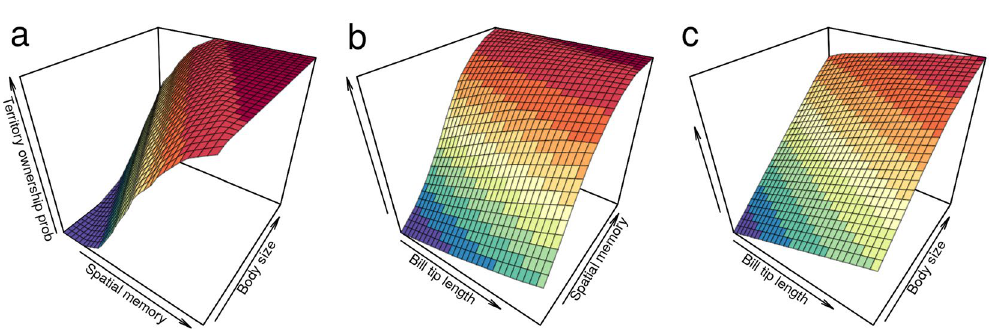
Figure 3. Three-dimensional surfaces of the predicted probability of territory ownership (z axis) for the combinations of the three traits that showed a significant effect. Probability of territory ownership was predicted based on the best mixed-effects model in the model selection procedure (two predictors at a time in the x and y axes). Values were predicted for all possible combinations of predictors (across 30 equally spaced values within the observed range) and random effect